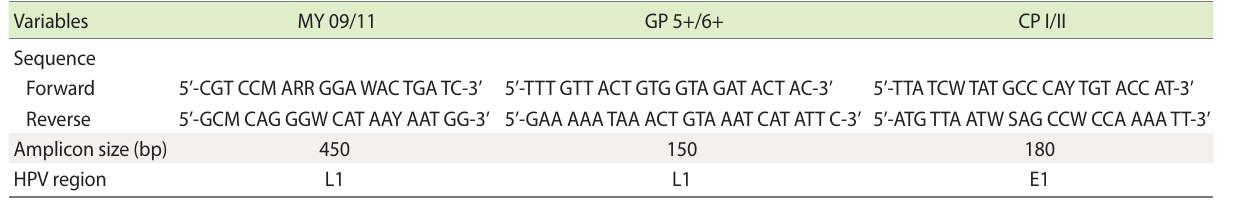
Table 1. Primer sequence, amplicon size and region specificity of degenerative primer sets Variables